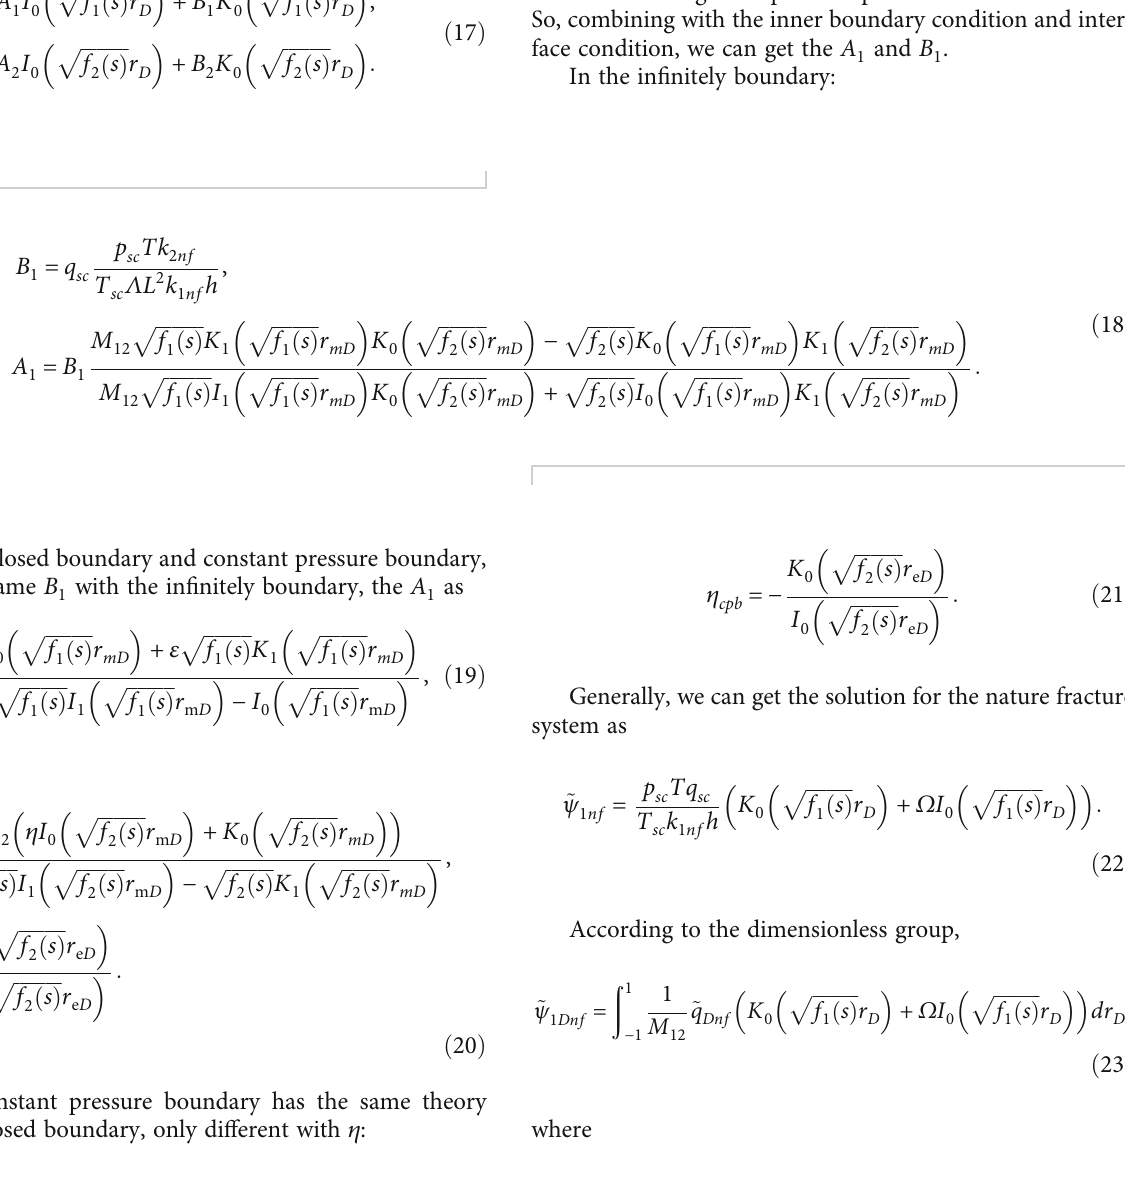
ffiffiffiffiffiffiffiffiffiffi